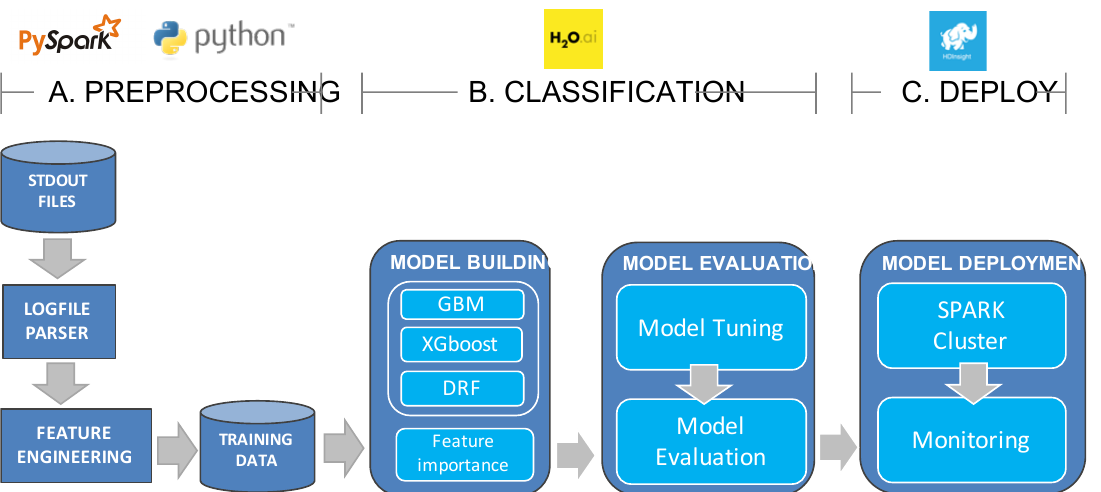
Figure 2. Data processing and data science module overview Flowchart diagram indicates the